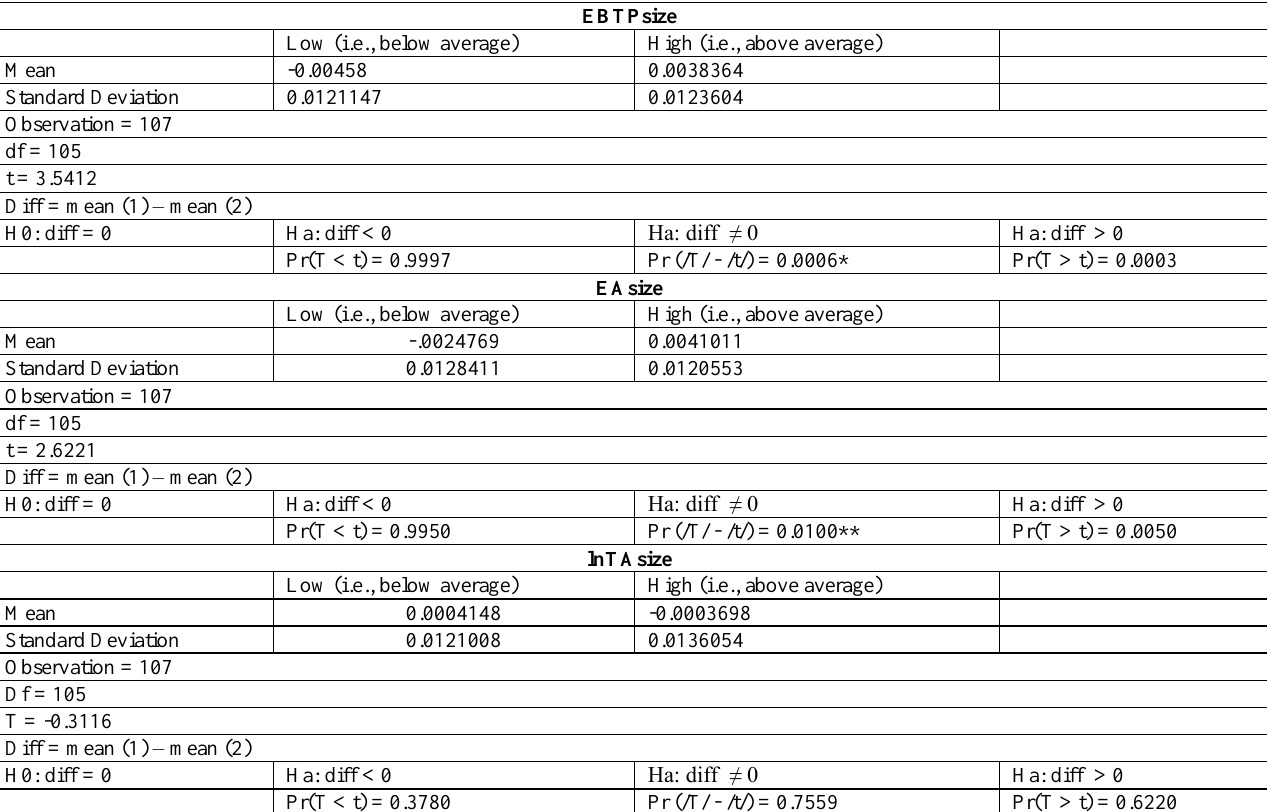
Table 4: Independent T-test